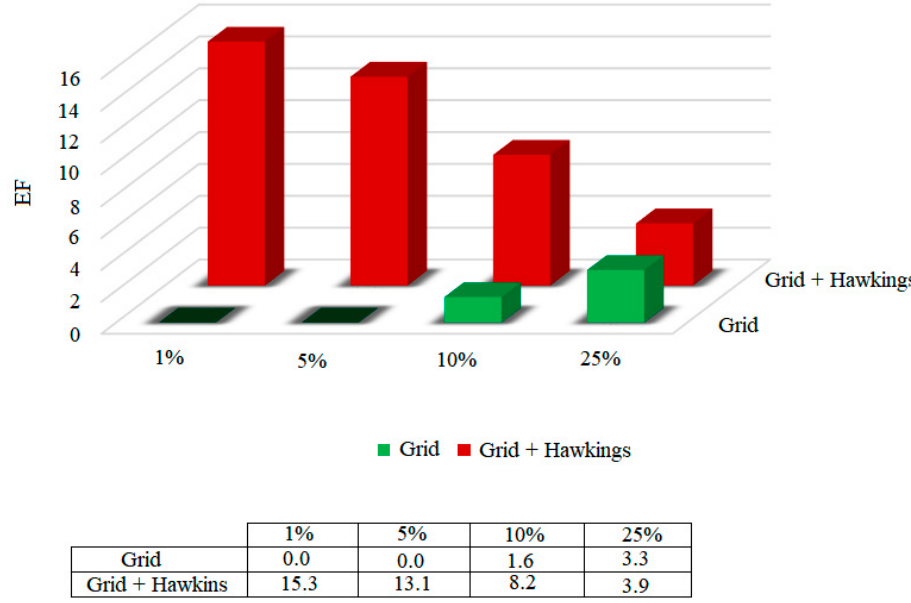
Figure 5. Enrichment factor (EF) for scoring functions used in MtKasA in 1, 5, 10 and 25% of the